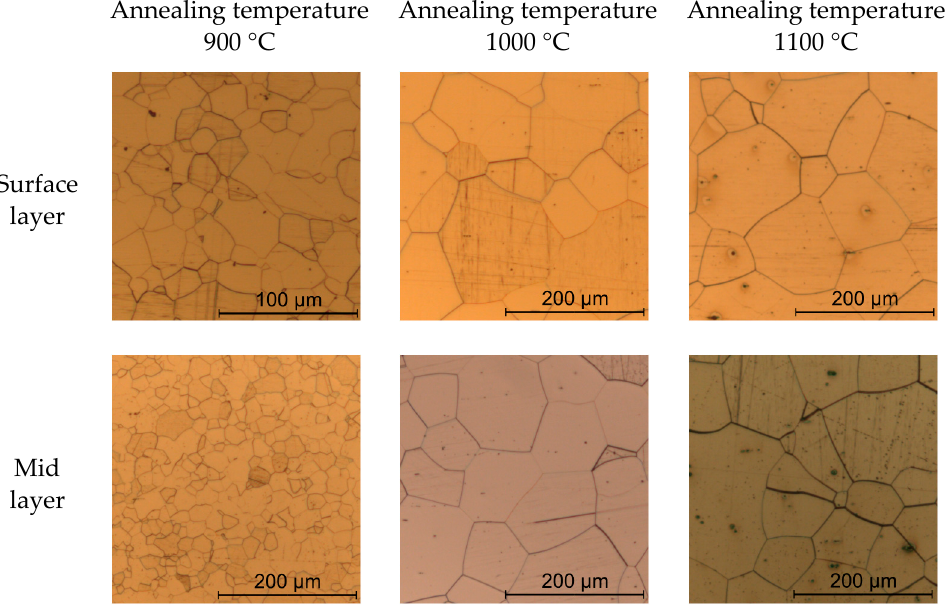
Figure 2. Microstructure images of steel sheets with 0.25 mm sheet thickness.